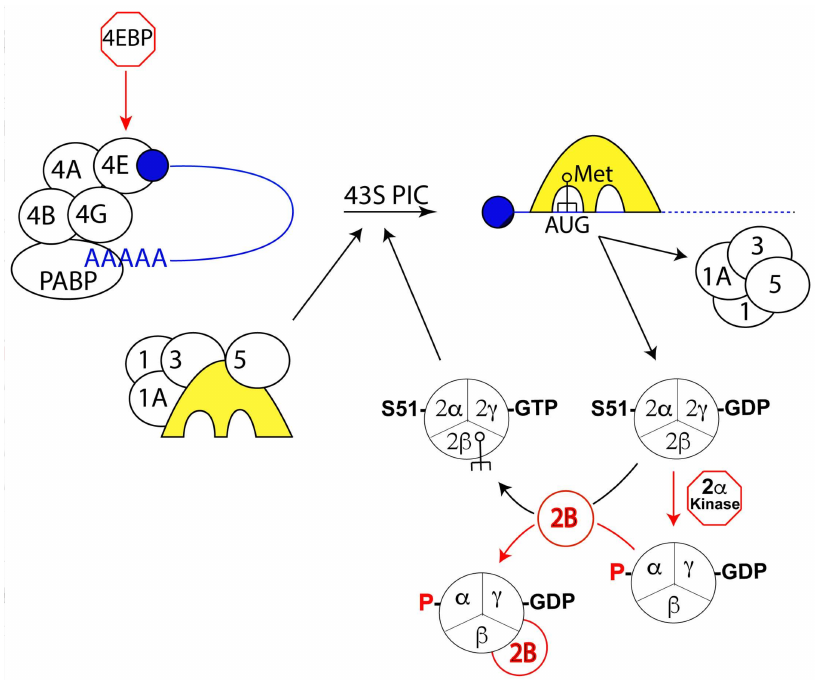
Figure 1. A schematic view of the factors involved in eukaryotic translation initiation. Transcripts (in blue) are present in the cytoplasm as a complex with the poly(A) binding protein (PABP), the cap-binding protein eIF4E, the scaffold protein eIF4G (linking PABP with the cap-binding protein) and two other initiation factors eIF4A and eIF4B. The 43S pre-initiation complex (43S PIC) is formed when the small ribosome subunit (yellow) in a complex with initiation factors eIF1, 1A, 3 and 5 binds the trimeric eIF2, which contains a tRNA charged with methionine (Met-tRNA i ). The small ribosome subunit moves down the RNA sequence until the anticodon on the Met-tRNA i recognizes and binds the AUG start codon. This recognition allows hydrolysis of the GTP bound to eIF2, causing release of the eIF2 from the PIC along with the eIF1, eIF1A, eIF3 and eIF5. The GTP-bound form of eIF2 is regenerated by the guanine exchange factor eIF2B. Translation can be globally downregulated by phosphorylation of eIF2 α , which then tightly binds eIF2B thus impeding recycling of eIF2. Orthologues for a GCN-type eIF2 α kinase and the cap-binding regulatory protein 4E-BP have not been identified in the dinoflagellate transcriptome sequence assembly